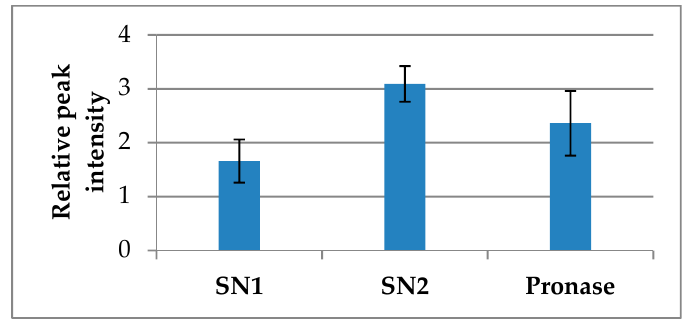
Figure 3 . Partitioning of ubiquinones between free (supernatants, SN1 and SN2) and protein-bound fractions released by protease digestion (Pronase).